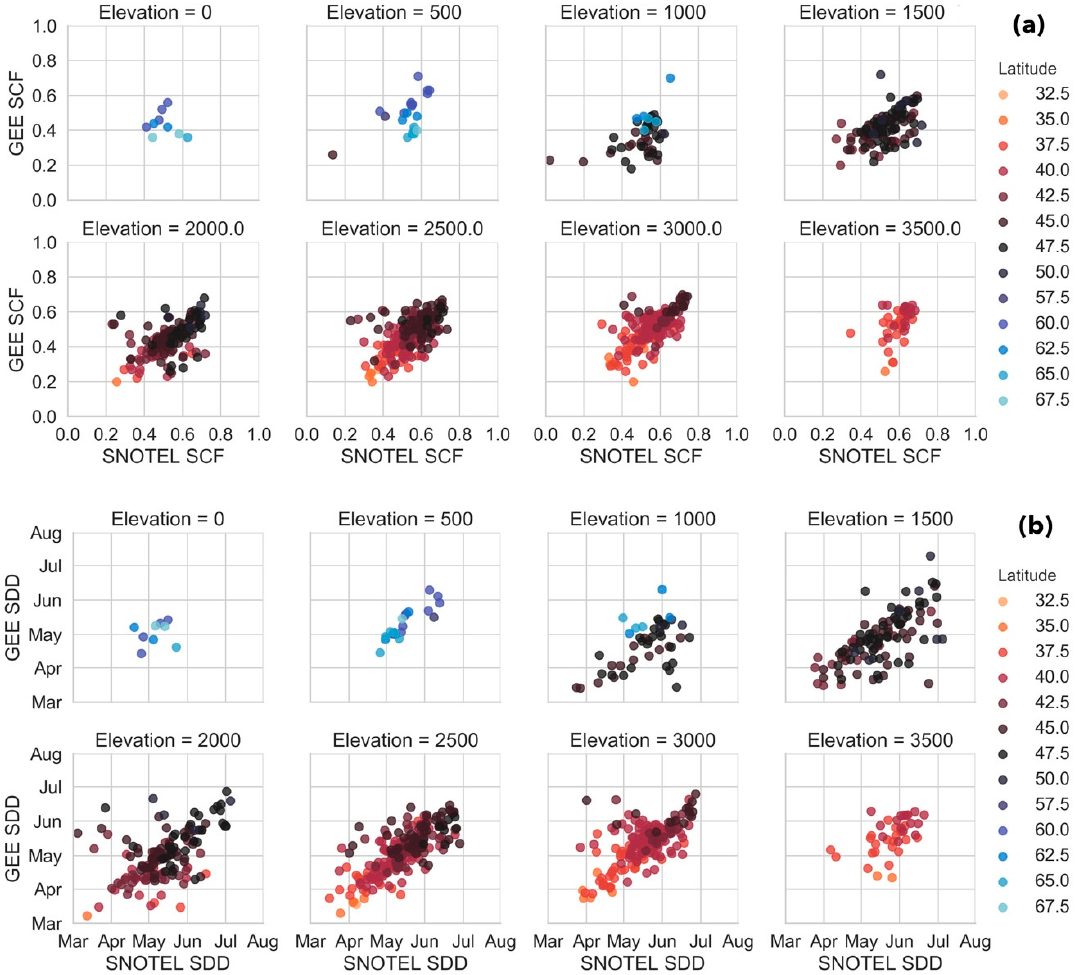
Figure 5. The GEE- and SNOTEL- derived SCF ( a ) and SDD ( b ) values at each station location subset by elevation and colored by latitude. Elevation bins are +/ − 250 with the exception of the first bin that includes elevations from 0 to 250 m.